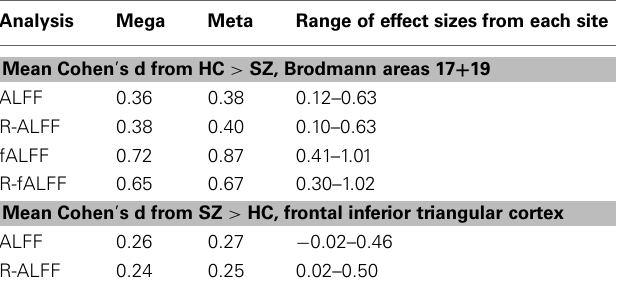
Table 5 | Comparison of the mean Cohen’s d from the mega-analysis and from the meta-analysis, for selected regions of interest in the original ALFF, fALFF and regressed fALFF(R-fALFF), separately for HC > SZ and SZ > HC analyses.